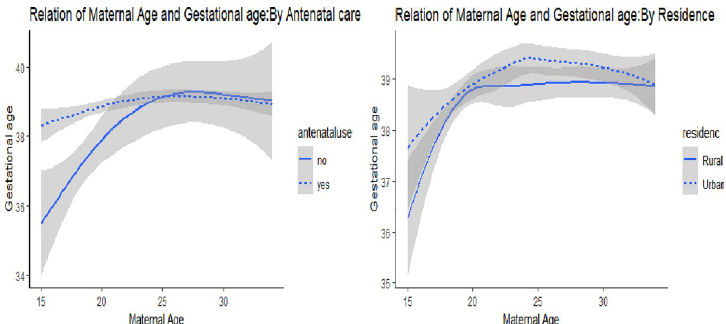
Fig 2. The relationship of women’s age and gestational age at birth by antenatal use and residence among women who gave birth in public health facilities, East Gojjam zone, Northwest Ethiopia, 2018.